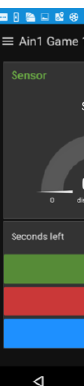
Figure 4. Screenshot of the software for the game prototype.